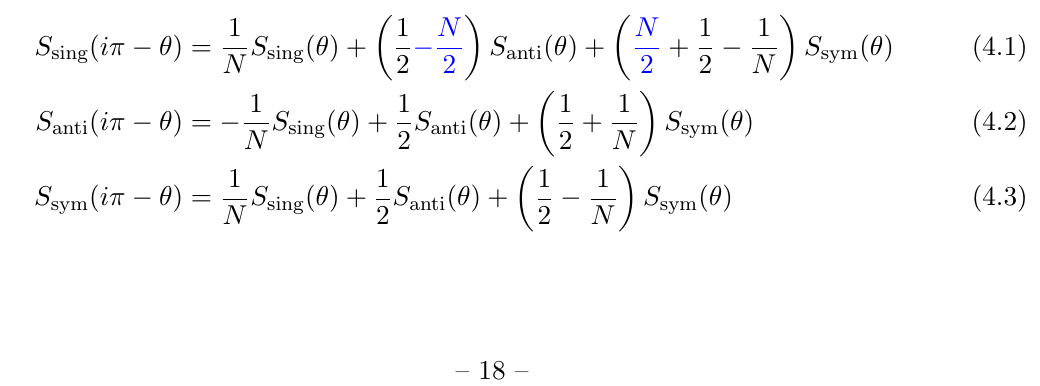
Figure 9 . ( a ) Analytic structure for S anti ( s ) for a theory with a single singlet bound state with maximal cubic coupling. Note the presence of zeroes in the left cut of the physical sheet and the t-channel pole depicted in blue. The red line above the right cut is where we impose unitarity. ( b ) Numerical results for this case in various regions of the (cid:18) = (cid:11) + i(cid:12) plane with m singlet = and n grid = 70. In the top panel in green we see that there are in(cid:12)nitely many zeros (resonances) in the (cid:18) = (cid:11) + i(cid:25) line corresponding to the left cut in the Mandelstam plane. The middle panel in blue shows the t-channel pole. In the red bottom panel, the solid line (absolute value of the function) exhibits the saturation of unitarity, whereas the dashed and pointed lines (real and imaginary parts) show the oscillatory behaviour leading to the zeros of the top green panel. This very rich